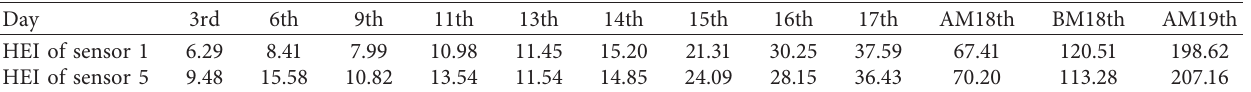
Figure 12: The HEI trend of two sensors, (a) the HEI trend of sensor 1, and (b) the HEI trend of sensor 5. Table 5: HEI of two sensors in each time point.